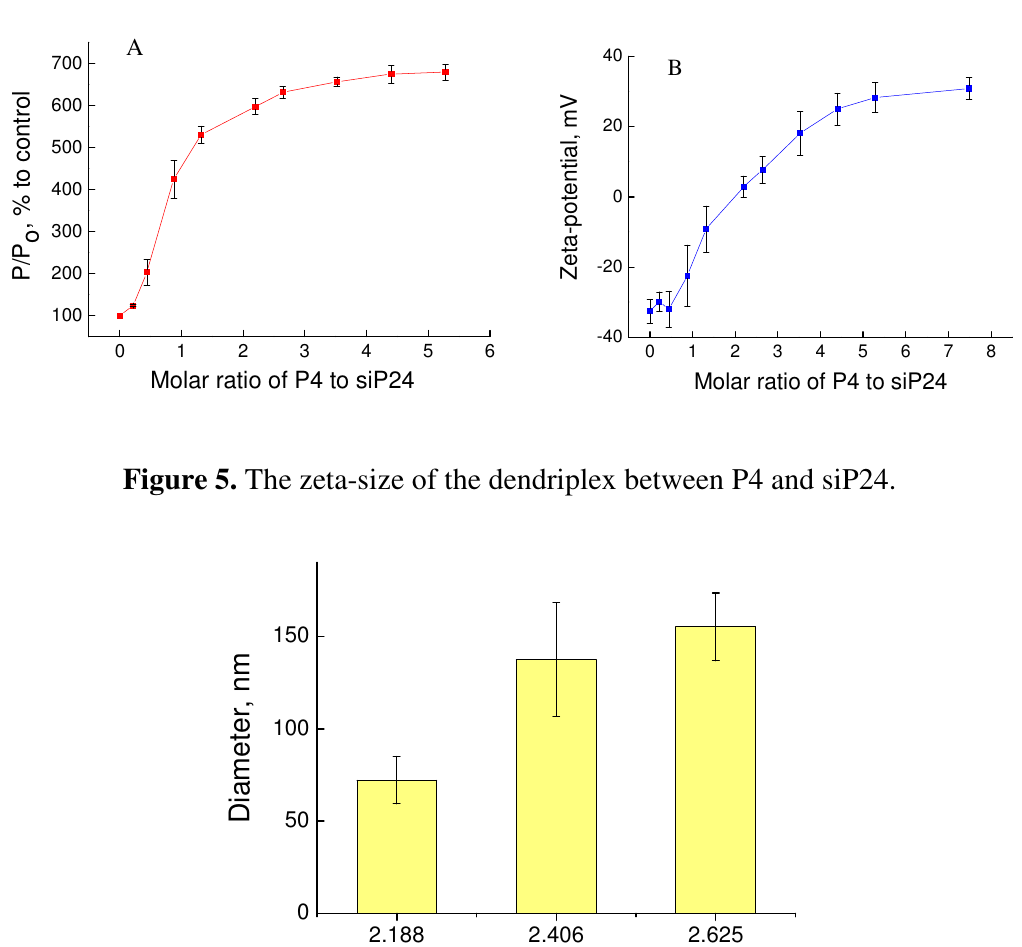
Figure 4. (a) Changes in fluorescence polarization of fluorescein labeled siP24 upon addition of various concentrations of P4. (b) Changes in zeta-potential of siP24 upon addition of various concentrations of P4. A: [siP24] = 0.1 µ mol/L. B: [siP24] = 0.25 µ mol/L.